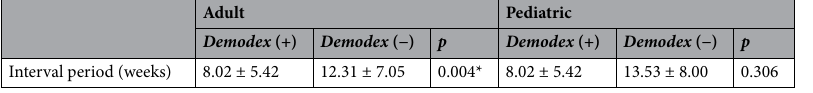
Table 3. The interval period of recurrent